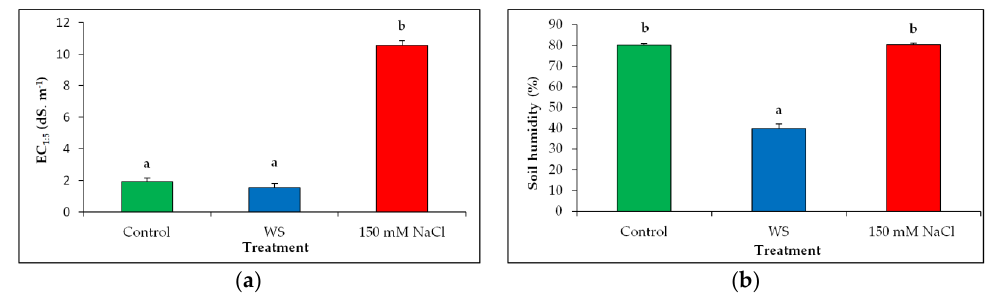
Figure 1. Substrate electric conductivity (EC 1:5 ) ( a ), and humidity (%); ( b ) after 30 days of water deficit (WS) or salt stress (150 mM NaCl). Bars represent means with SE ( n = 7). Different letters above the bars indicate significant differences between treatments, according to Tukey’s test ( α = 0.05).